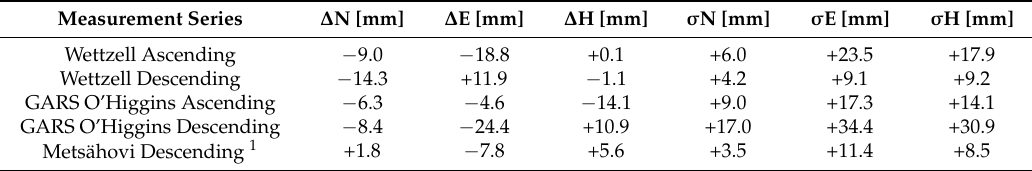
Table 10. Differences of the TerraSAR-X coordinates using the updated orbits and the reference coordinates in the global ITRF2014 expressed in local north, east and height. The variances of the TerraSAR-X solution mark the 95% confidence interval of the estimated coordinates.